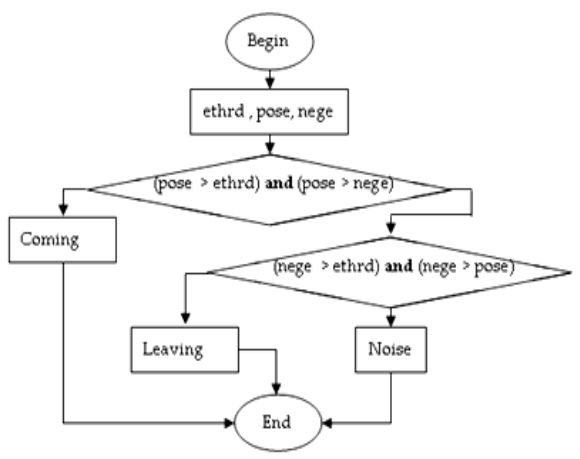
Figure 13. Flowchart gestures classifier algorithm and noise. Algorithm 2: Classification algorithm for gesture and noise